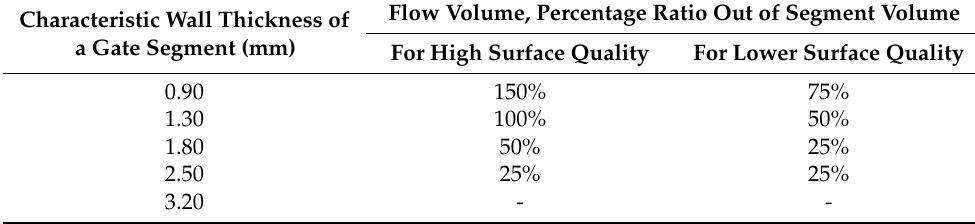
Table 3. Recommended volumes of